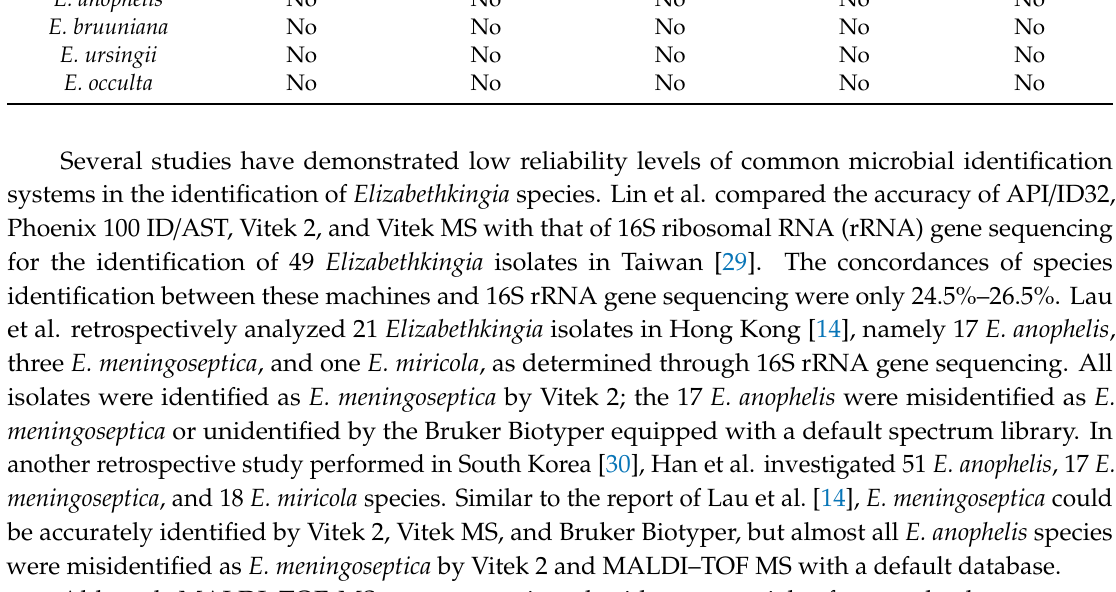
Phoenix 100 ID / AST